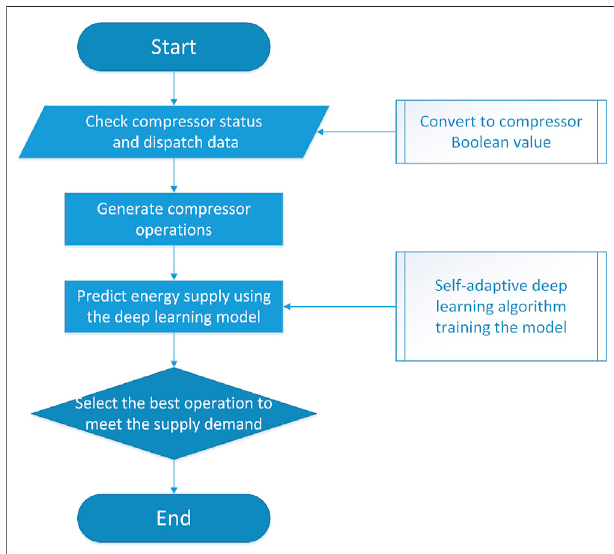
FIGURE 1 | Flowchart of the intelligent dispatch